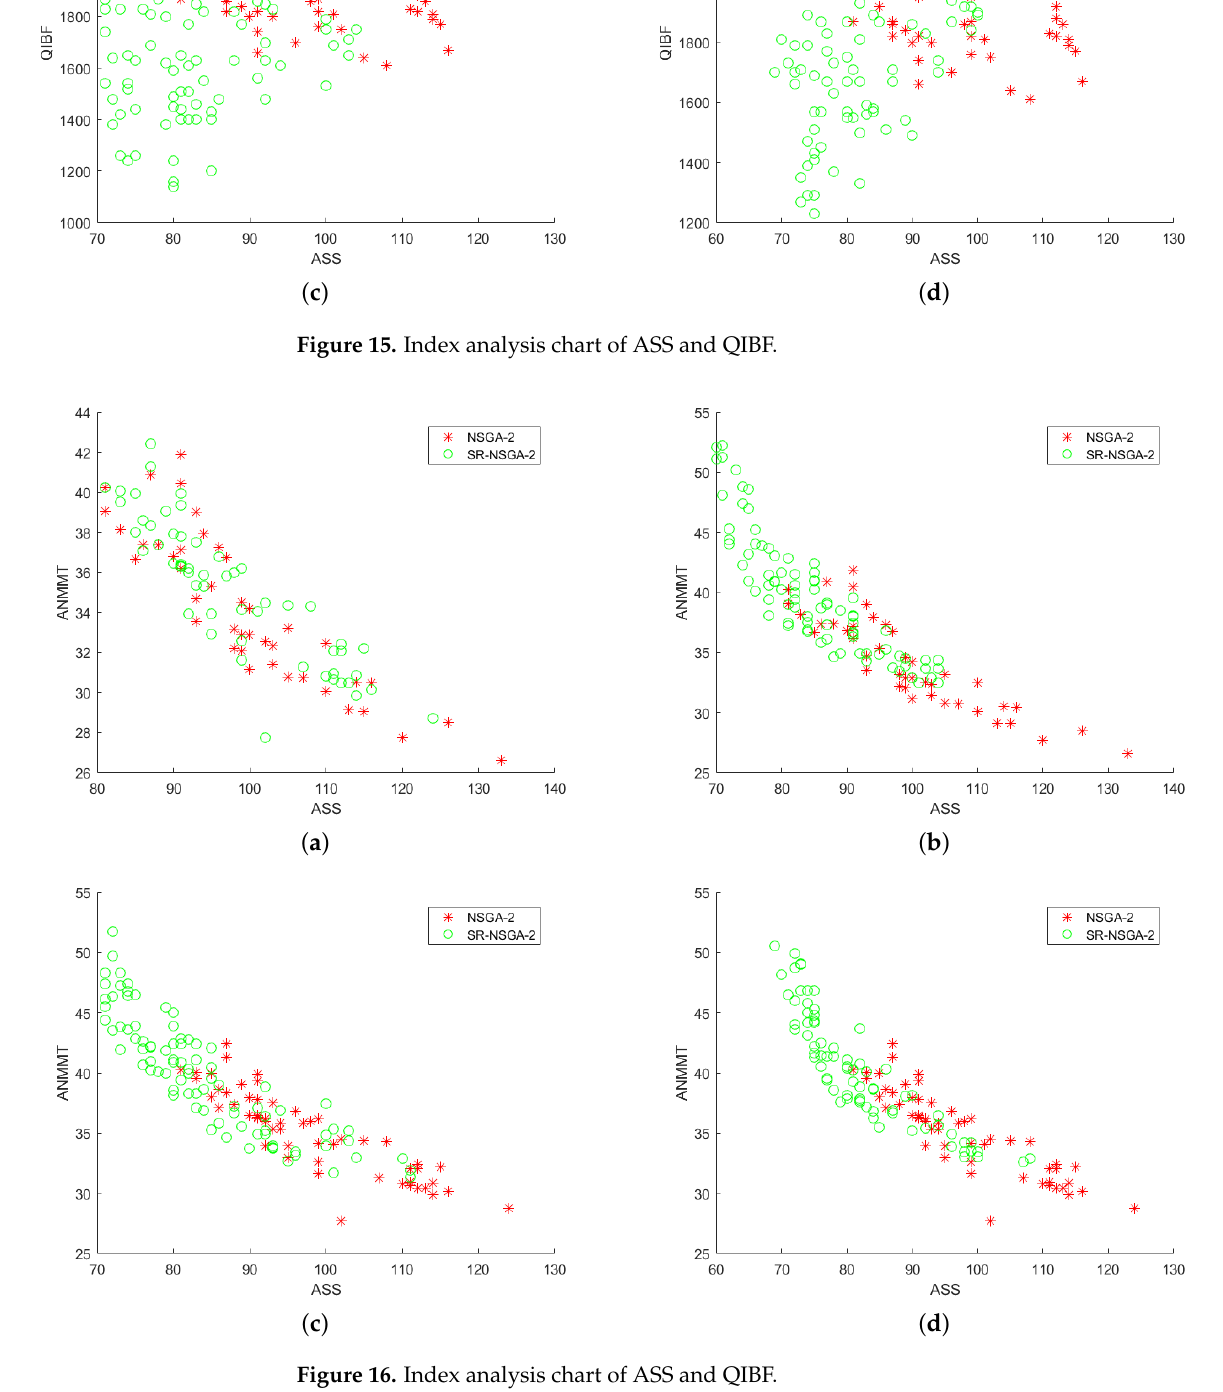
Figure 16. Index analysis chart of ASS and